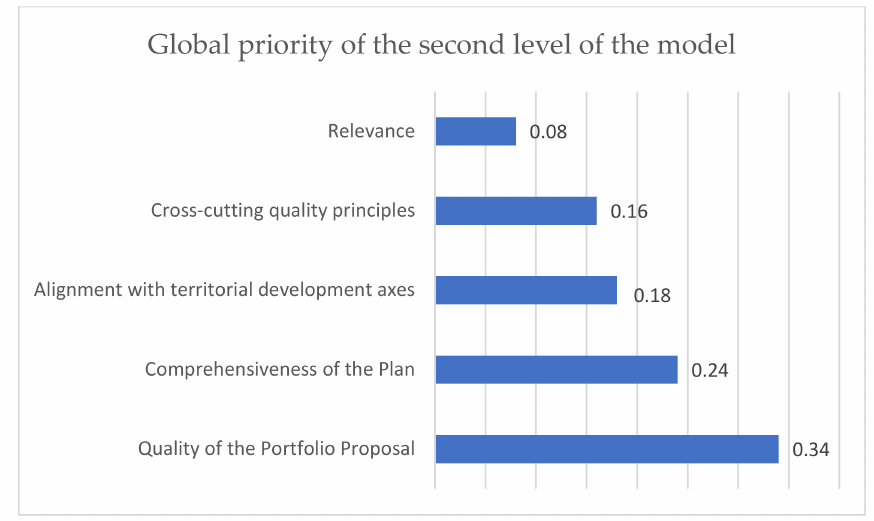
Figure 5. Priorities of the model